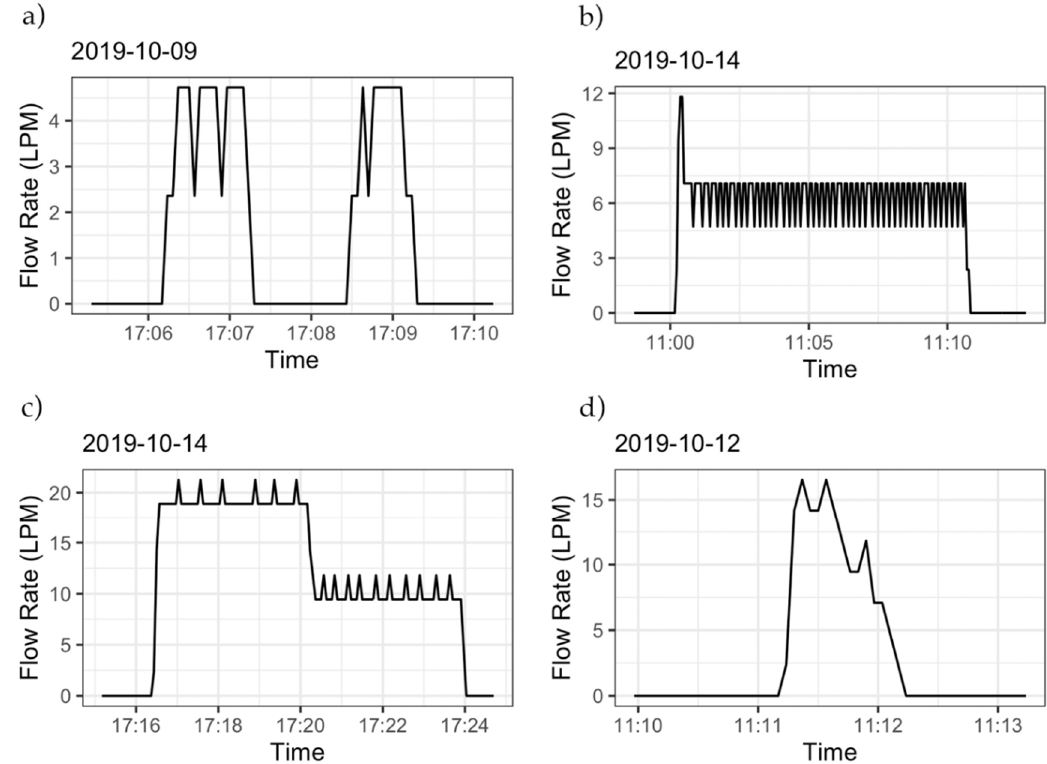
Figure 9. Flow rate signatures for events labeled by the homeowner at Site 1. Panel ( a ) two subsequent faucet events, ( b ) a shower event, ( c ) a clothes washer event, and ( d ) a toilet flush event.